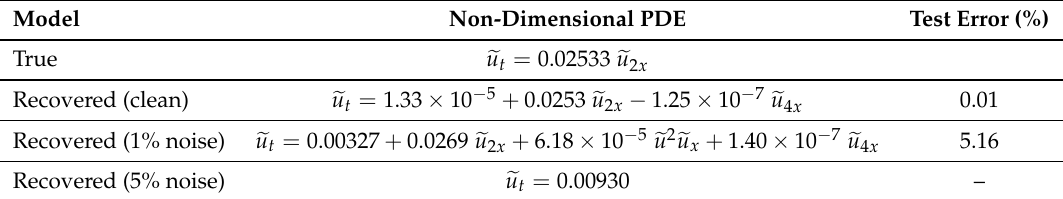
Figure 4. Non-dimensional analytical solution of heat equation. Table 5. Identifying heat equation using